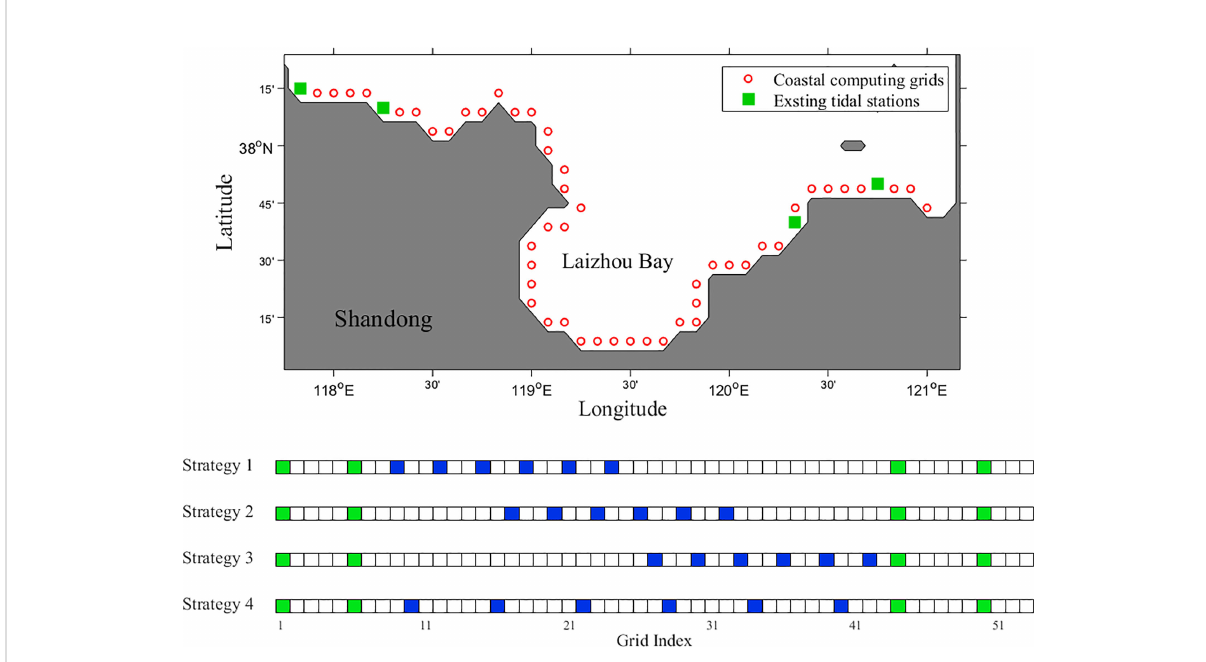
FIGURE 6 The map of subdomain in the south of the Bohai Sea and four different siting strategies in the form of grid (the green grids represent existing tidal stations and the blue grids represent new tidal